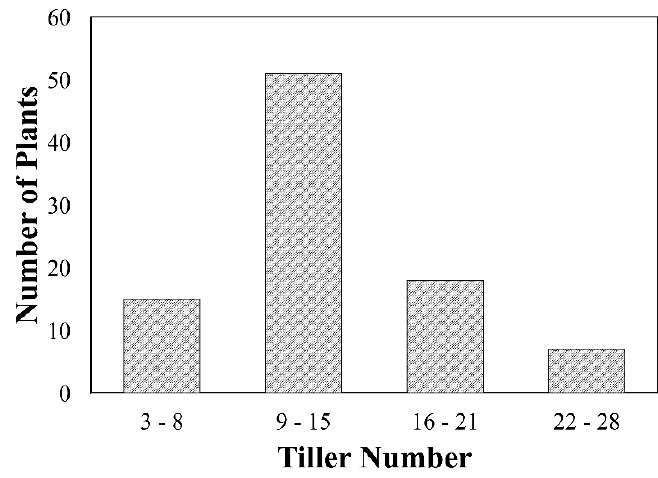
Figure 4. Tiller number distribution in the F 2 population. The average number of tillers for parents Indian and Icaro were 11 and 12, respectively.